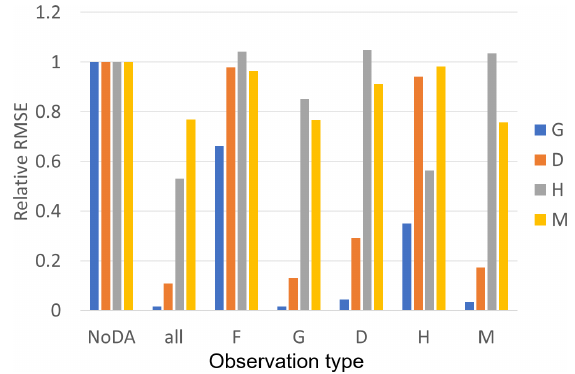
Figure 3. The ratio of RMSEs of the no data assimilation (NoDA) experiment to those of the data assimilation (DA) experiments in which all of observations ( F , G , D , H , and M ) are assimilated (all), and each one of them is assimilated in experiment 1 (see Sect. 3.1.1). Blue, orange, gray, and yellow bars are the RMSEs of the size of the human settlement G(t) , the center of the mass of the human settlement from the river D(t) , the flood protection level (or levee height) H(t) , and the social awareness of the flood risk M(t)